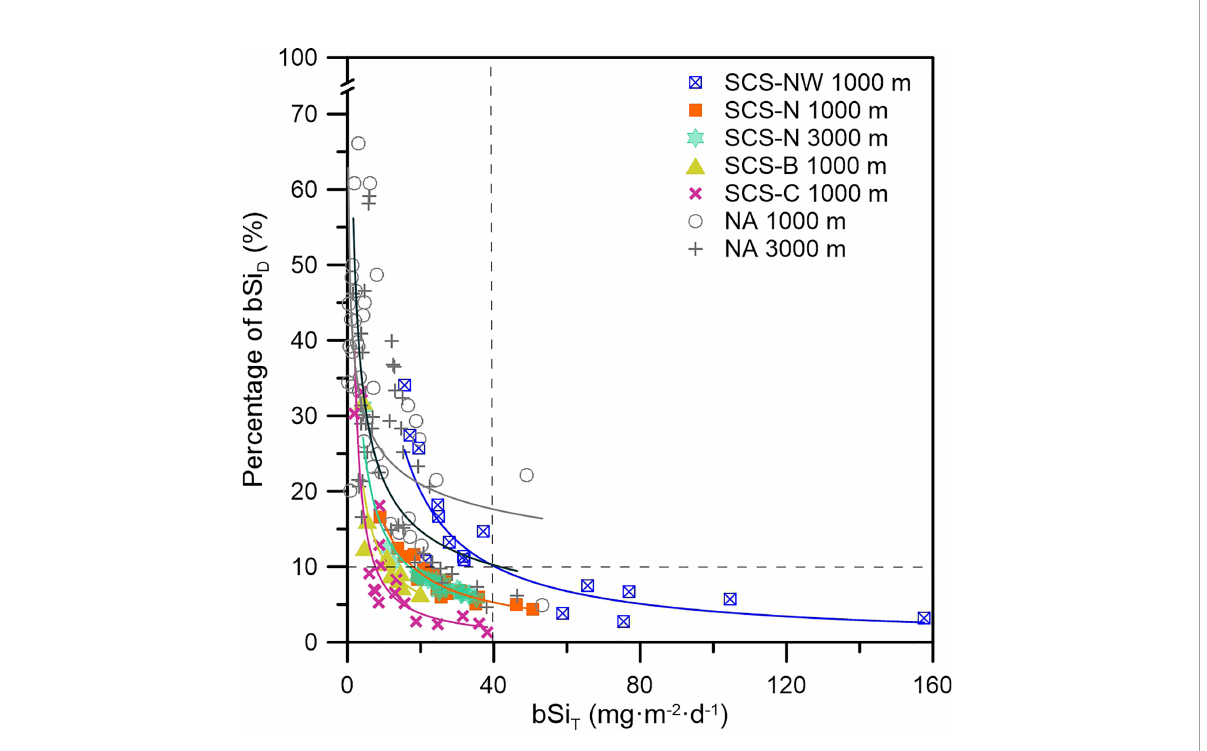
FIGURE 8 Percentage of the bSi D as a function of the bSi T fl ux at the different stations in the SCS and North Atlantic Ocean [NA, North Atlantic; data retrieved from Gallinari et al.